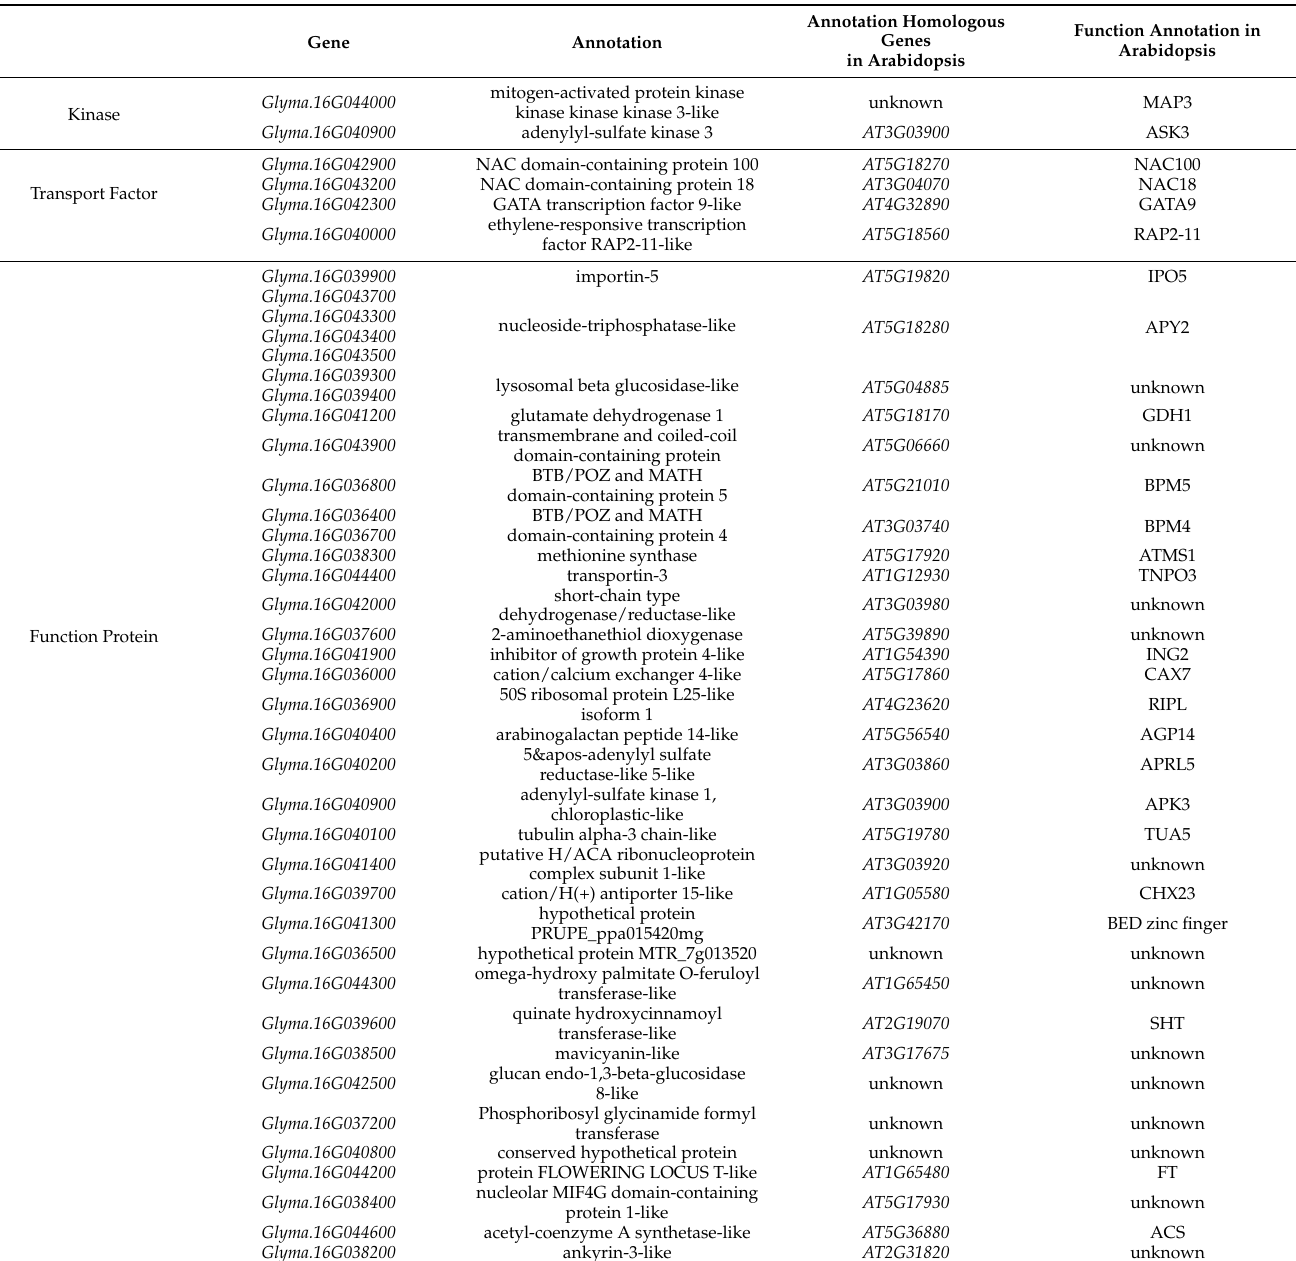
Table 3. Annotation and classification of candidate genes within NNMS-localized QTL